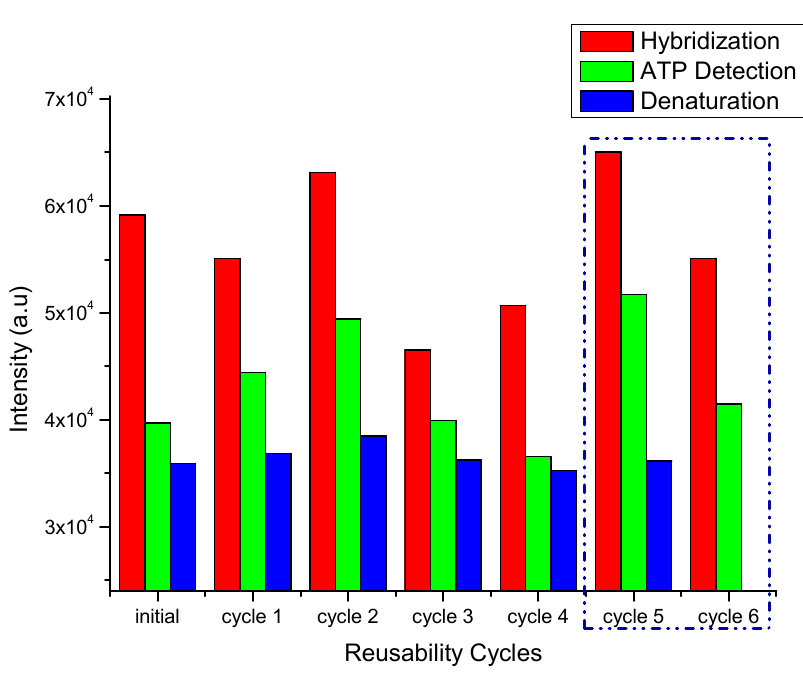
Figure 8. Reusability of the aptasensor for seven cycles over two weeks.